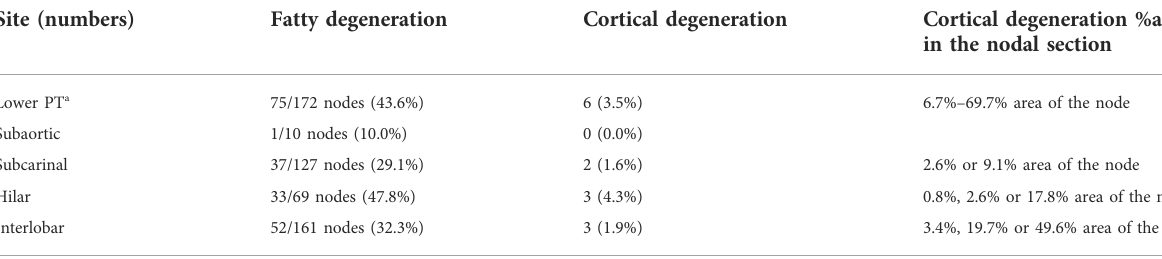
TABLE 3 Cortical degeneration and fatty degeneration in thoracic